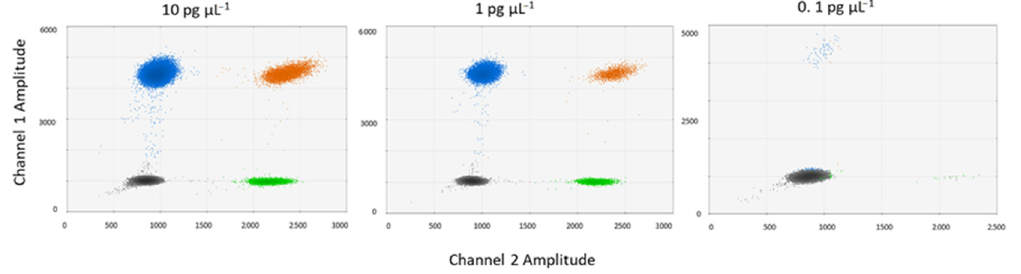
Figure 4. Effect of template DNA c oncentration on ddPCR quantification. Shown are 2D-scatter plots for three different template DNA concentrations containing both giant virus and virophage DNA at equal concentrations (three technical replicates). For color schemes see Figure 2.